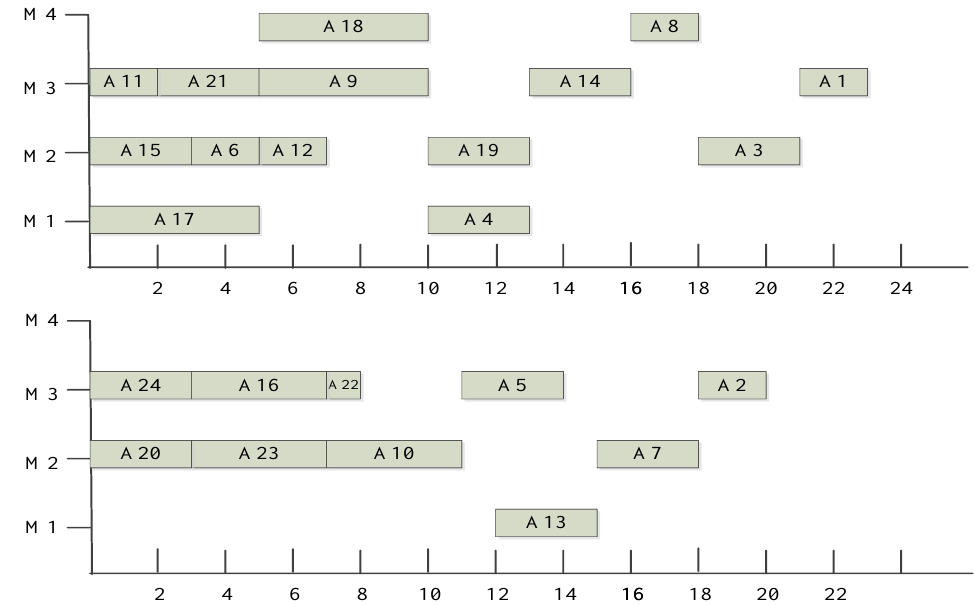
Figure 8. Gantt chart of algorithm scheduling results in the Ref. [15].